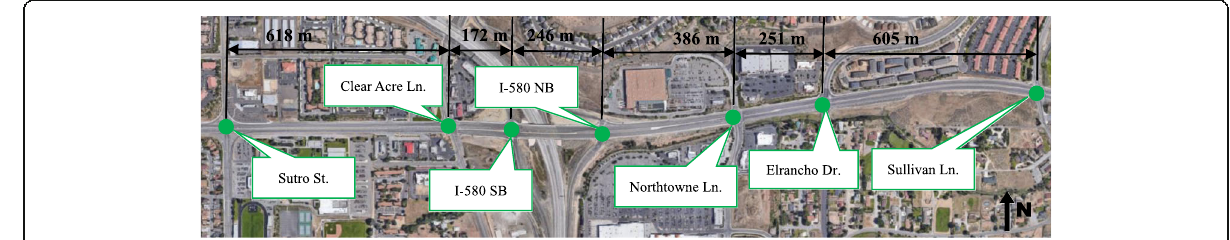
Fig. 2 Graphical illustration of the North McCarran Blvd signalized